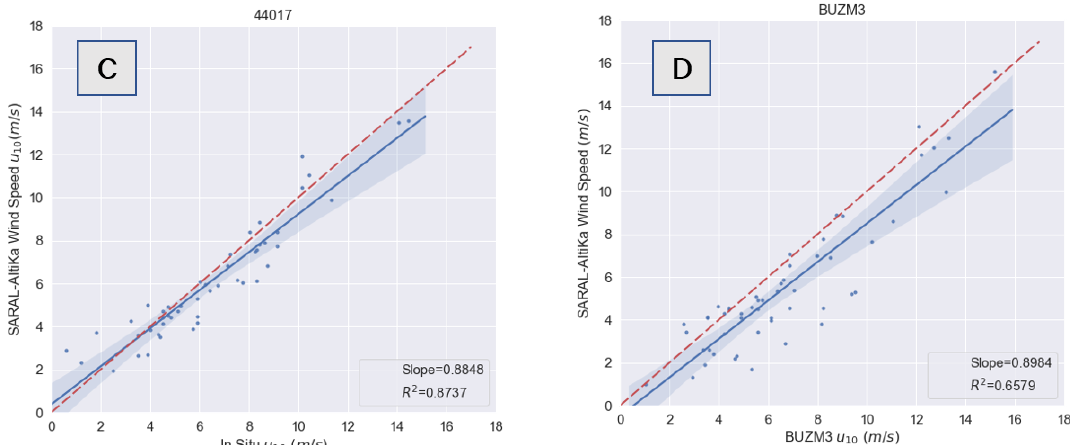
Figure 4. Comparison of 10-meter wind speed, u 10 , between SARAL/AltiKa and selected buoys at stations 44025 ( A ), 44039 ( B ), 44017 ( C ), and BUZM3 ( D ). Matched measurements denoted as blue dots are those falling within radius R p 25 . In each case, the fitting linear regression line is shown as a continuous blue line with their corresponding 99% confidence interval in shaded blue.